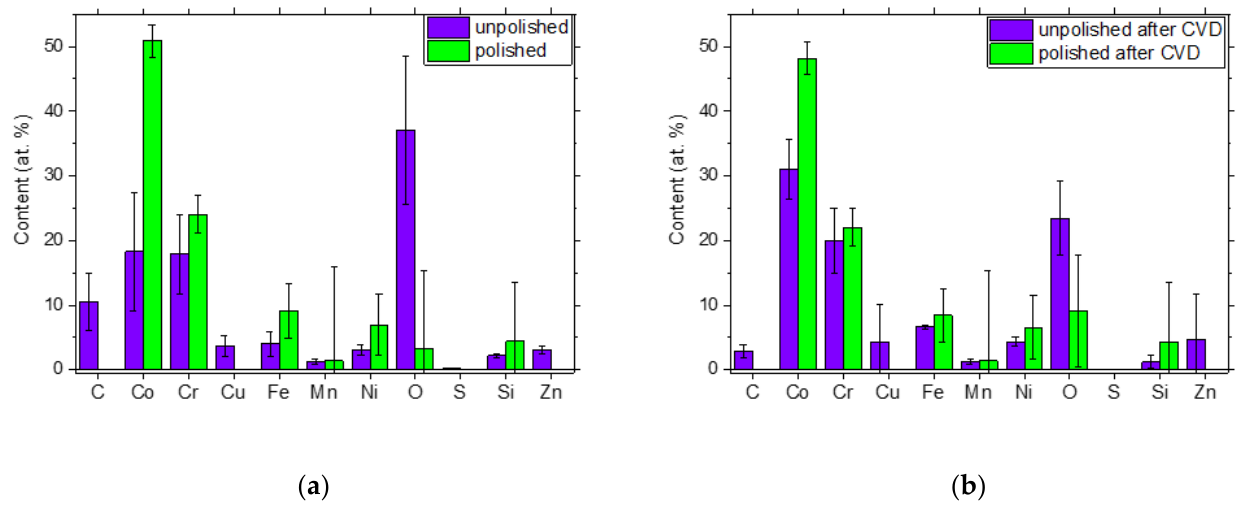
Figure 2. The averaged results of the energy dispersive X-ray spectroscopy (EDS) analysis performed for Co-Cr alloys before ( a ) and after graphene deposition ( b ).